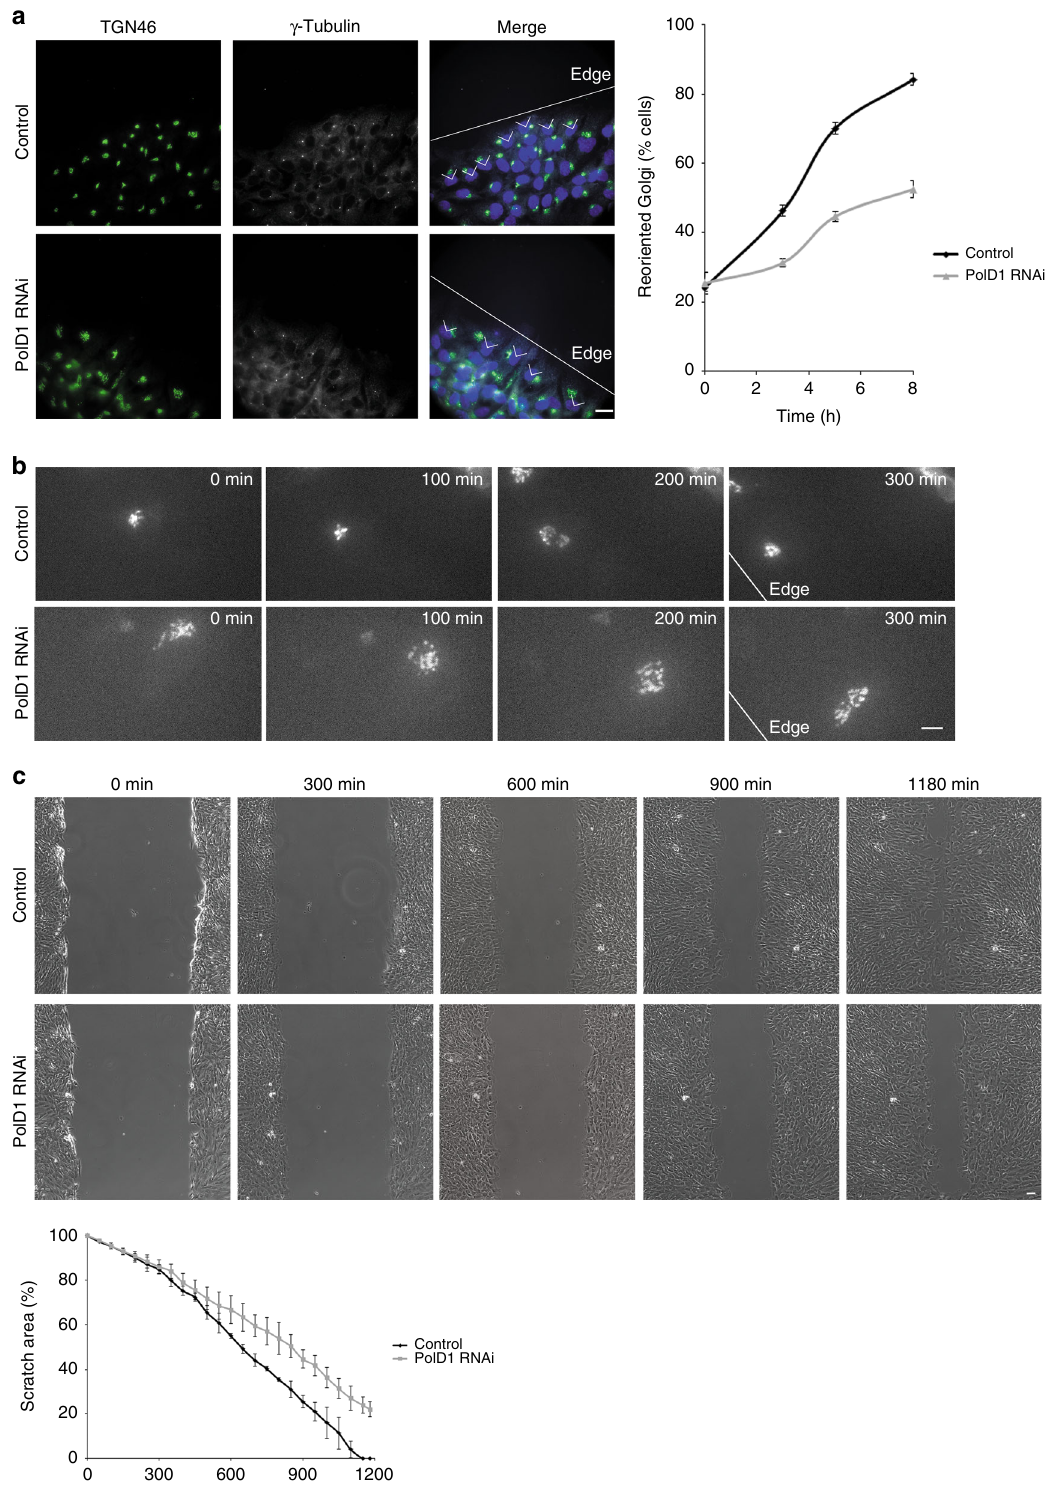
Fig. 7 Cell polarization is impaired in PolD1-depleted cells. a In a wound-healing assay, RPE1 cells were immunostained to analyze Golgi reorientation. DNA was stained with Hoechst 33258. White lines mark the scratch edges. The angles indicate orientation within 90° facing the scratch edge. Numbers of cells containing the reoriented Golgi are plotted as means ± s.e.m., and the graph is representative of results obtained in three independent experiments ( n = 200 cells for each condition). Scale bar , 20 μ m. b Movie frames of RPE1 cell imaging were selected at the indicated time points after scratching. The cells were transfected with Venus- β -1,4-galactosyltransferase. Shown are representatives of 30 observed cells per condition. Scale bar , 10 μ m. c A wound-healing assay was performed using RPE1 cells; selected phase-contrast movie frames are shown. The percentages of scratch area at each time point are shown as means ± s.e.m. The graph is representative of results obtained in three independent experiments. Scale bar , 20 μ